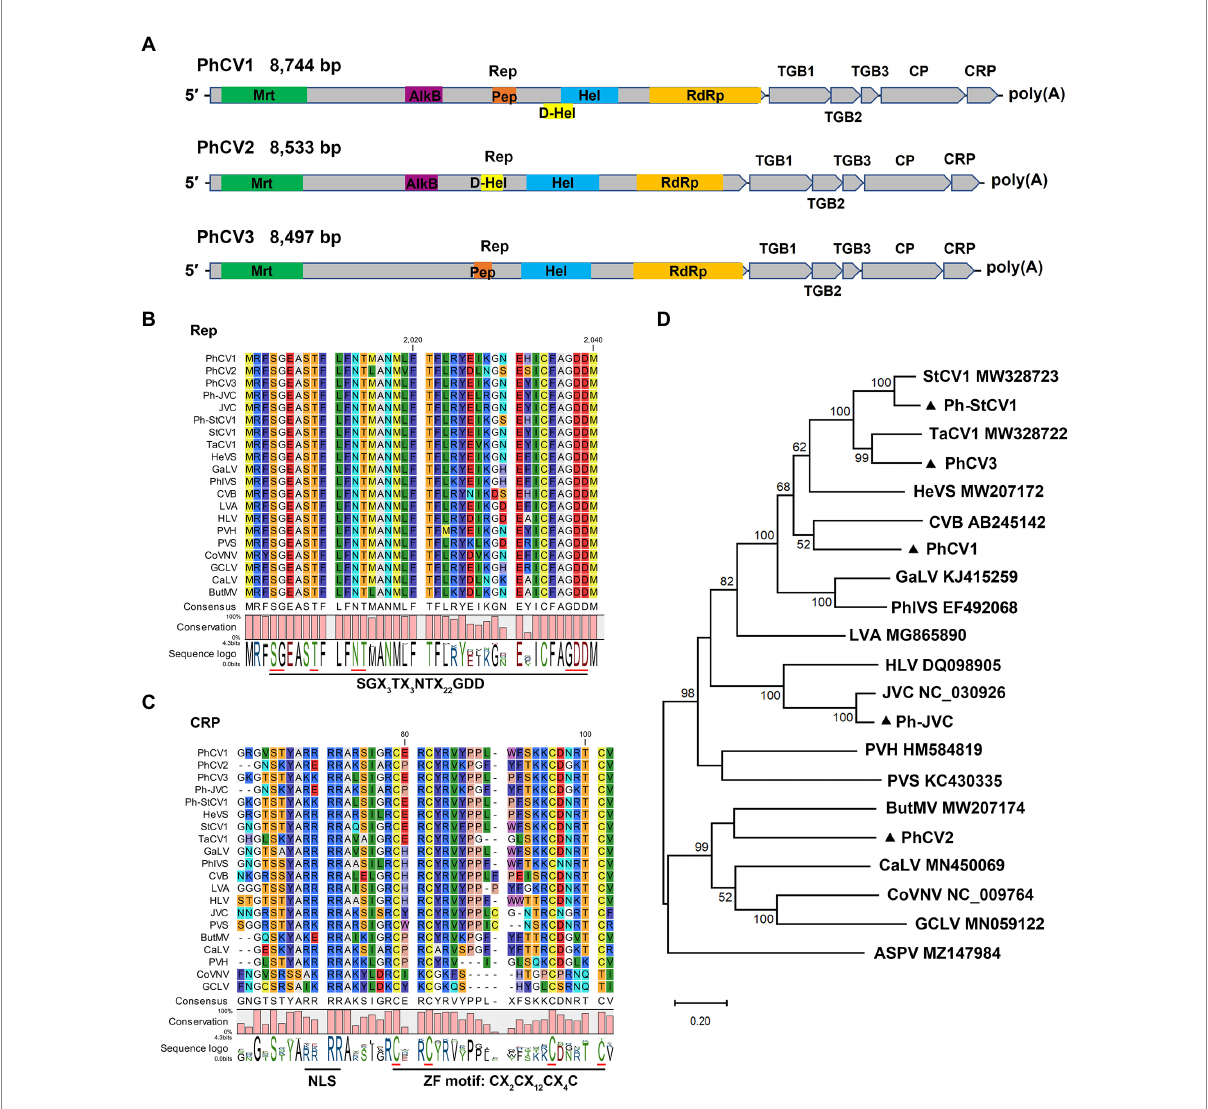
FIGURE 4 Characterization of three novel carlaviruses, pseudostellaria heterophylla carlavirus 1 (PhCV1), pseudostellaria heterophylla carlavirus 2 (PhCV2), and pseudostellaria heterophylla carlavirus 3 (PhCV3) isolated from Pseudostellaria heterophylla in China. (A) Genomic organization of PhCV1, PhCV2, and PhCV3. Rep, viral replicase; TGB, triple gene block; CP, coat protein; CRP, cysteine-rich protein; Mrt, methyltransferase; AlkB, alkylated DNA repair protein; Hel, viral helicase; D-Hel, DEAD-like helicase; Pep, Carlavirus endopeptidase; RdRp, RNA-dependent RNA polymerase. (B) Amino acid alignment between the conserved RdRp motifs of PhCV1, PhCV2, PhCV3, Ph-JVC, and Ph-StCV1 and 15 selected carlaviruses. (C) Amino acid alignment between NLS and ZF in the CRP of PhCV1, PhCV2, PhCV3, Ph-JVC, Ph-StCV1, and 15 selected carlaviruses. NLS, nuclear localization signal. ZF, zinc finger-like motif. (D) Phylogenetic analysis based on the amino acid sequences of the Rep of PhCV1, PhCV2, PhCV3, Ph-JVC, Ph-StCV1, and the 15 most similar carlaviruses, performed by the maximum-likelihood method in MEGA X software. Bootstrap values (1,000 replicates) are shown below the branches. The black triangles represent carlaviruses identified in this study.